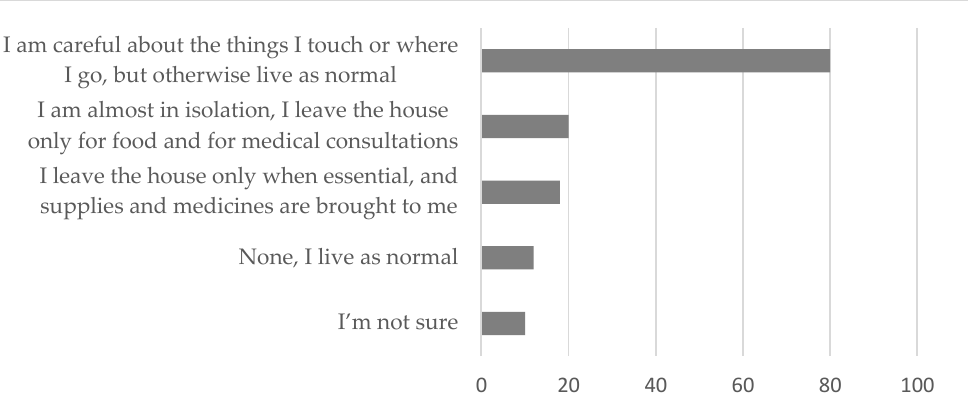
Figure 5. Impact of the pandemic on the daily life of people with AD.